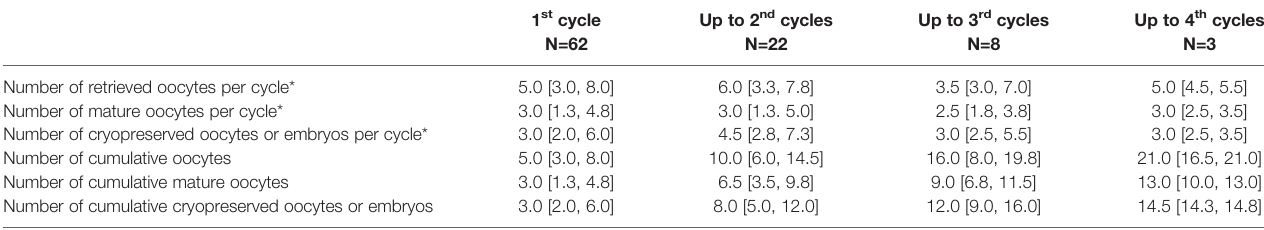
TABLE 5 | Cumulative effect of cryopreservation.